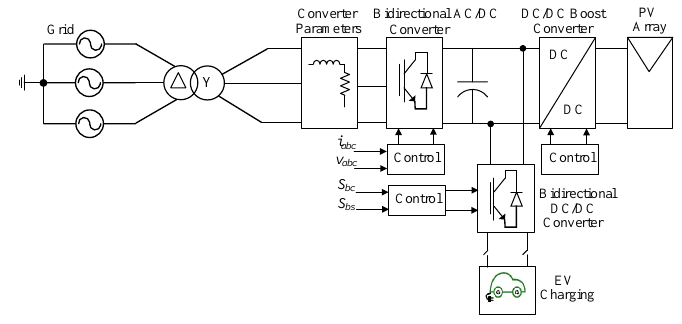
Figure 2. Charging station